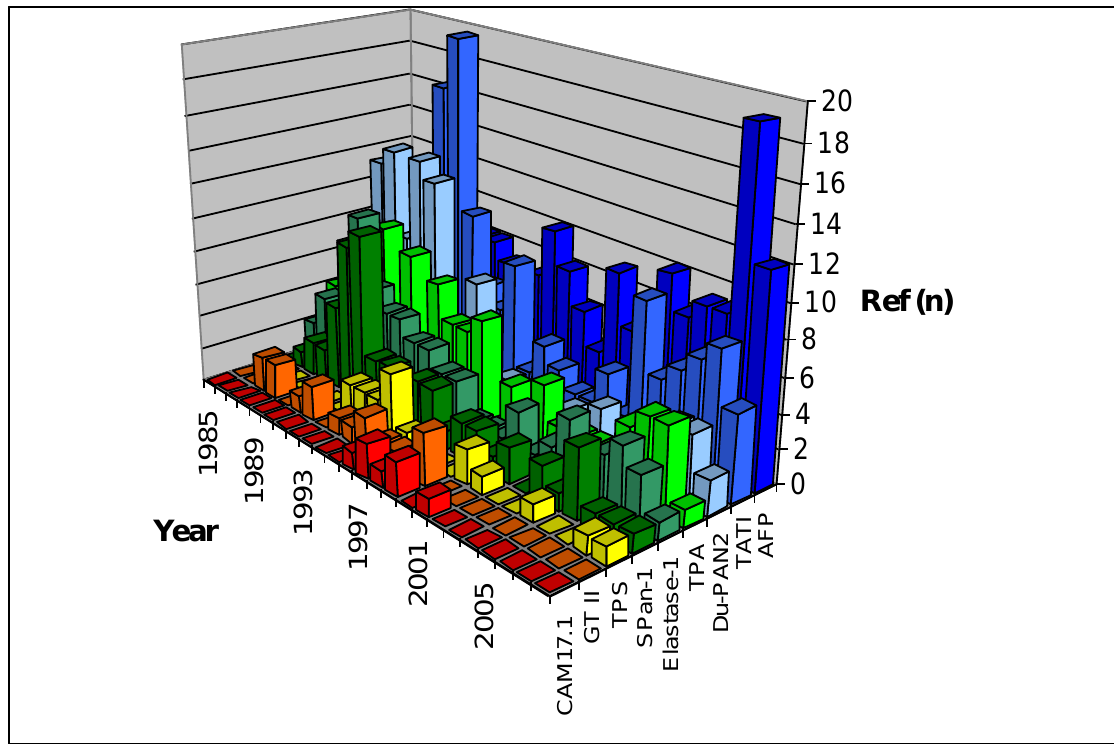
Figure 2. Results of the Pubmed search for references on cytokeratins, mucins and others in pancreatic cancer serum markers (GT II= Galactosyltransferase isoenzyme